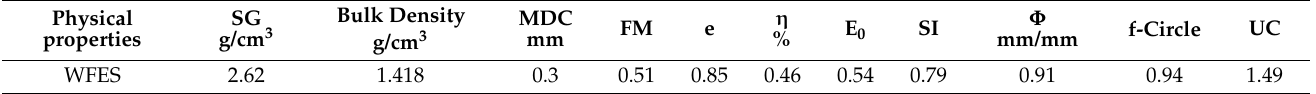
Figure 3. Waste foundry exhaust sand SEM micrograph, with details of shape and sphericity. Scale from 1 to 20 µ m and magnification of 500 × . Table 4. Characteristics determined for